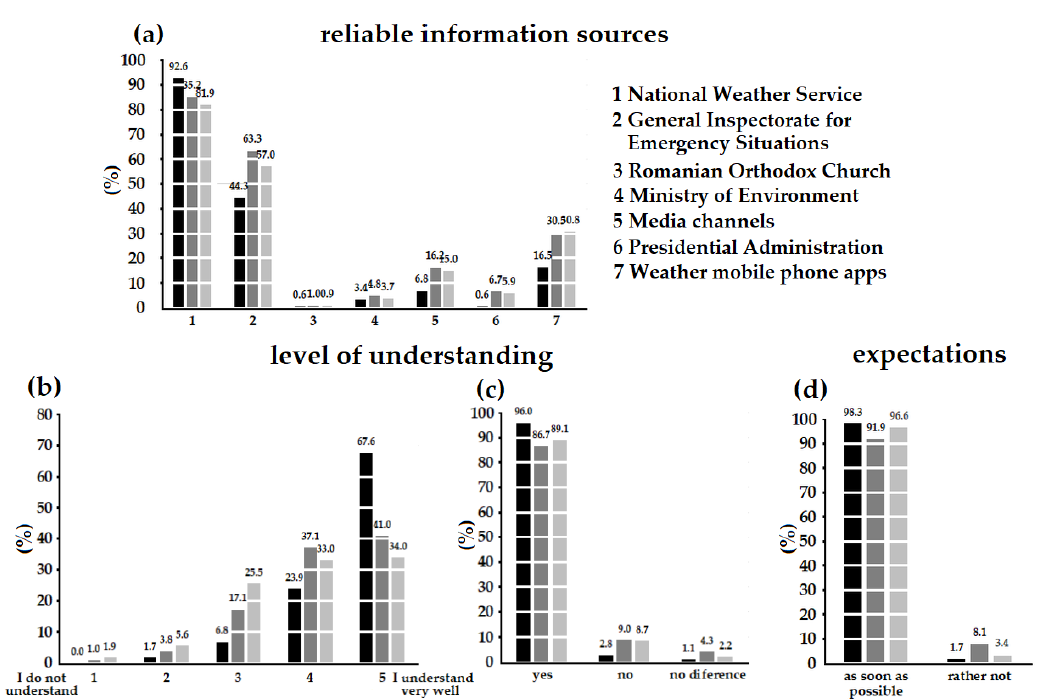
Figure 7. The distribution of results from sub-sets for questions Q6 to Q9 regarding: the most reliable information sources ( a ), understanding level of weather apps information ( b ), understanding level of weather service messages, ( c ) and peoples’ expectations regarding the warning messages ( d ).